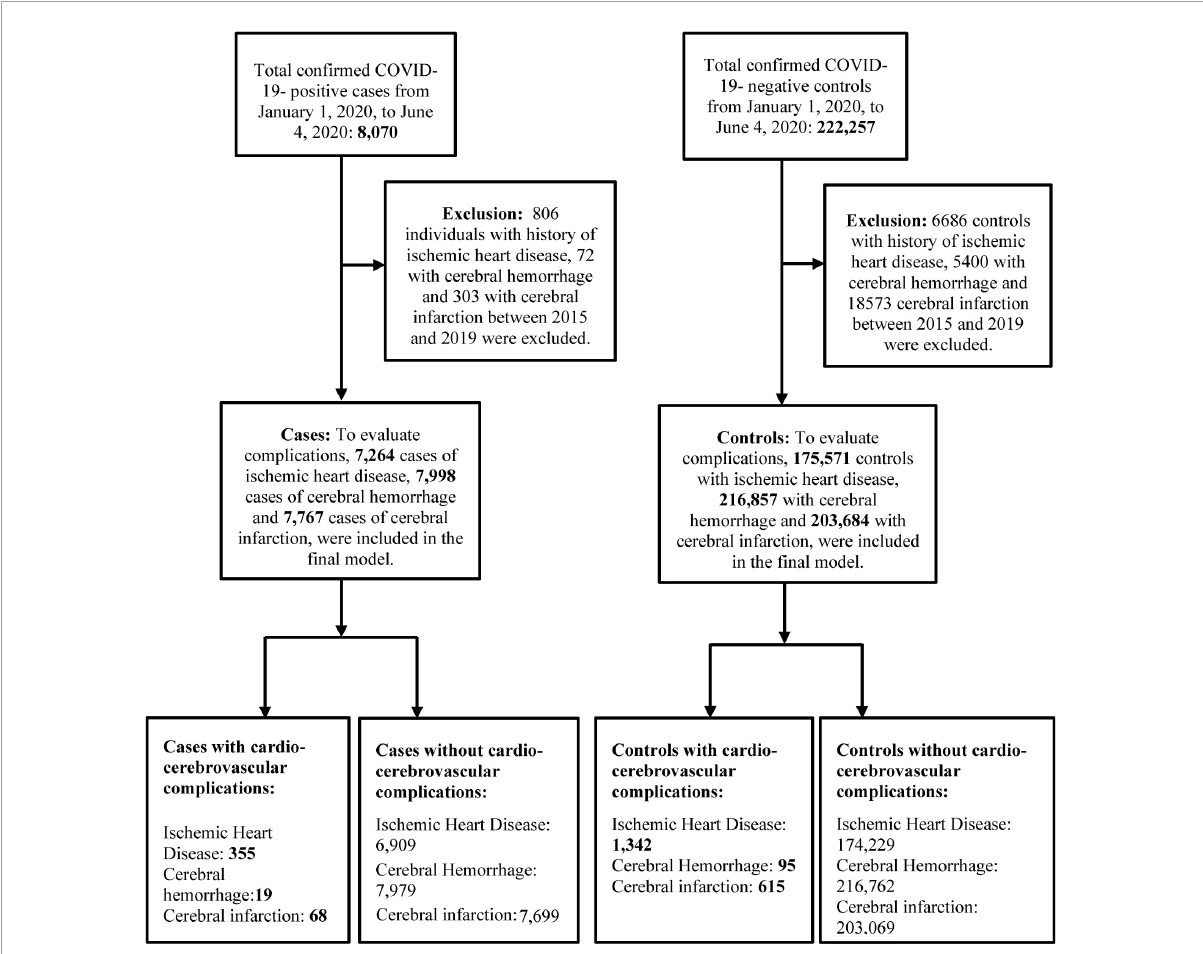
FIGURE1 Flowchart of the selection of study participants. Ischemic heart disease was diagnosed with I20–I25, cerebral hemorrhage with I60–I62 and cerebral infarction with I63 in ICD-10-Code. COVID-19, coronovirus disease